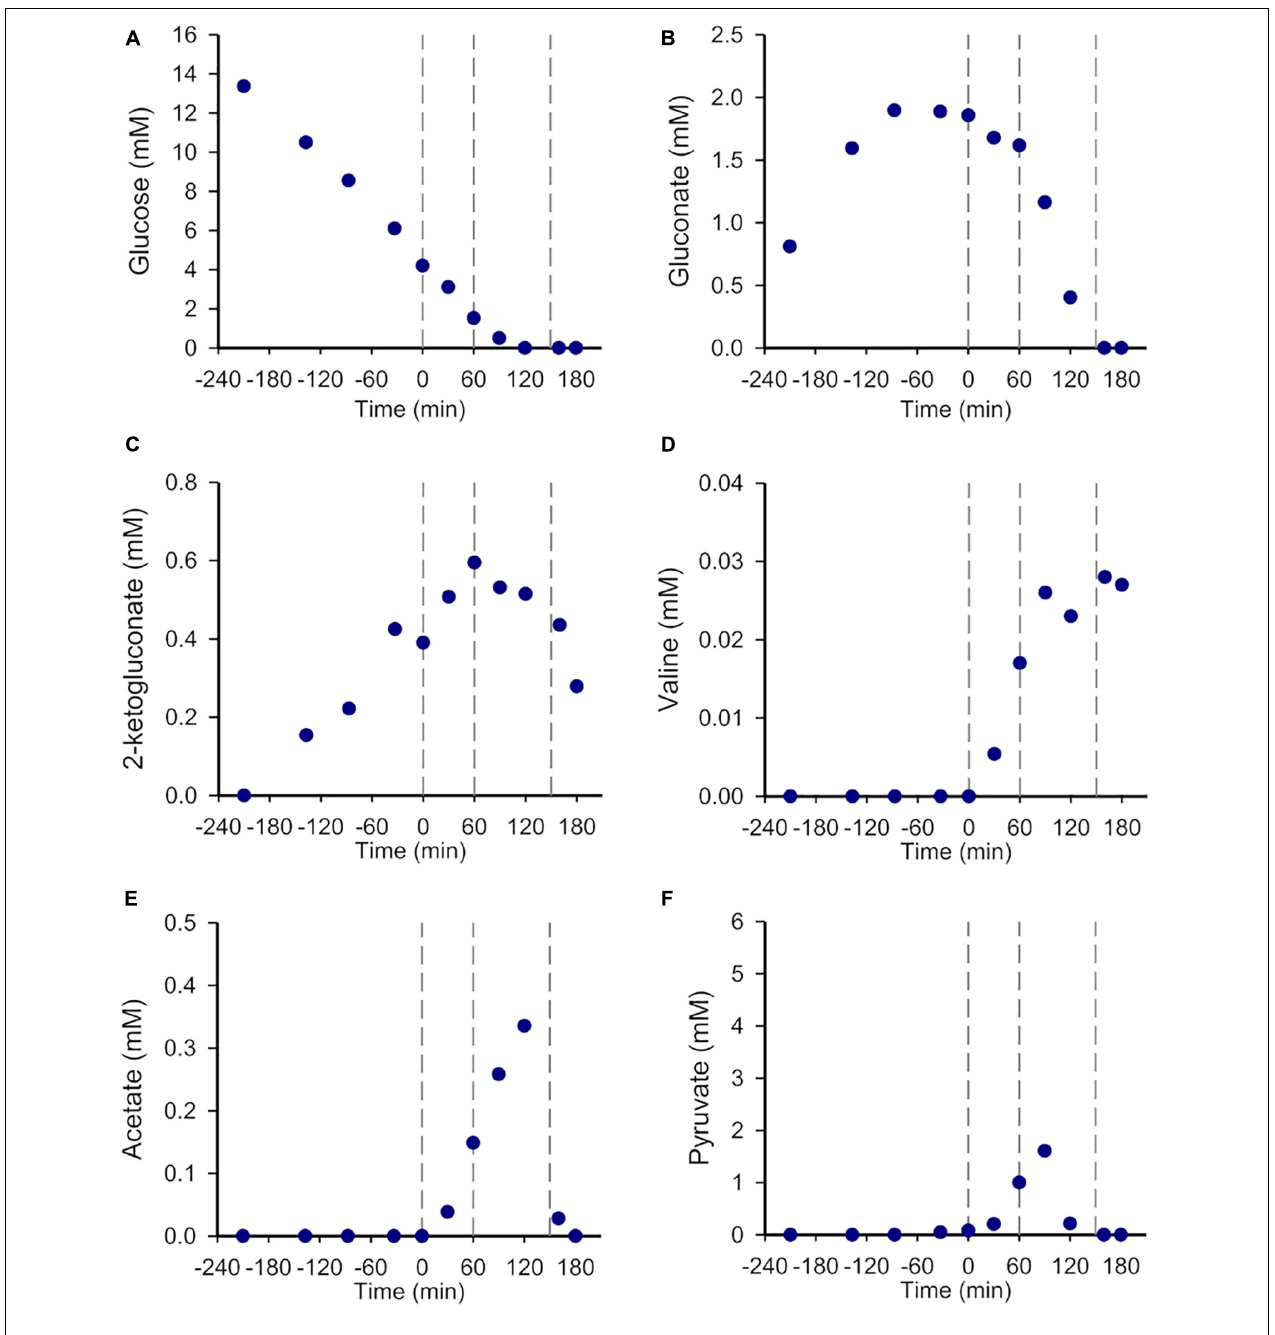
FIGURE 2 | The metabolism of P. putida KT2440 is dramatically altered but remains active after SHX addition. Time-evolutions of (A) glucose, (B) gluconate, (C) 2-ketogluconate, (D) valine, (E) acetate and (F) pyruvate concentrations (mM). The vertical dashed lines delimit the different growth phases (see Figure 1 ). The results obtained from the other biological replicates are shown in Supplementary Figure 2